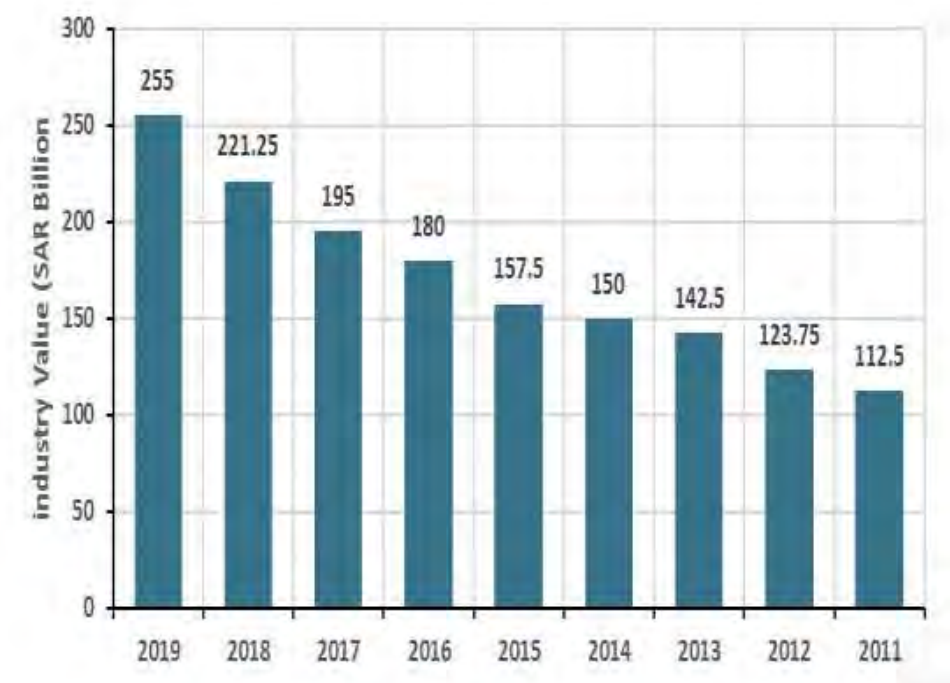
Figure 2. Construction Sector Value in KSA